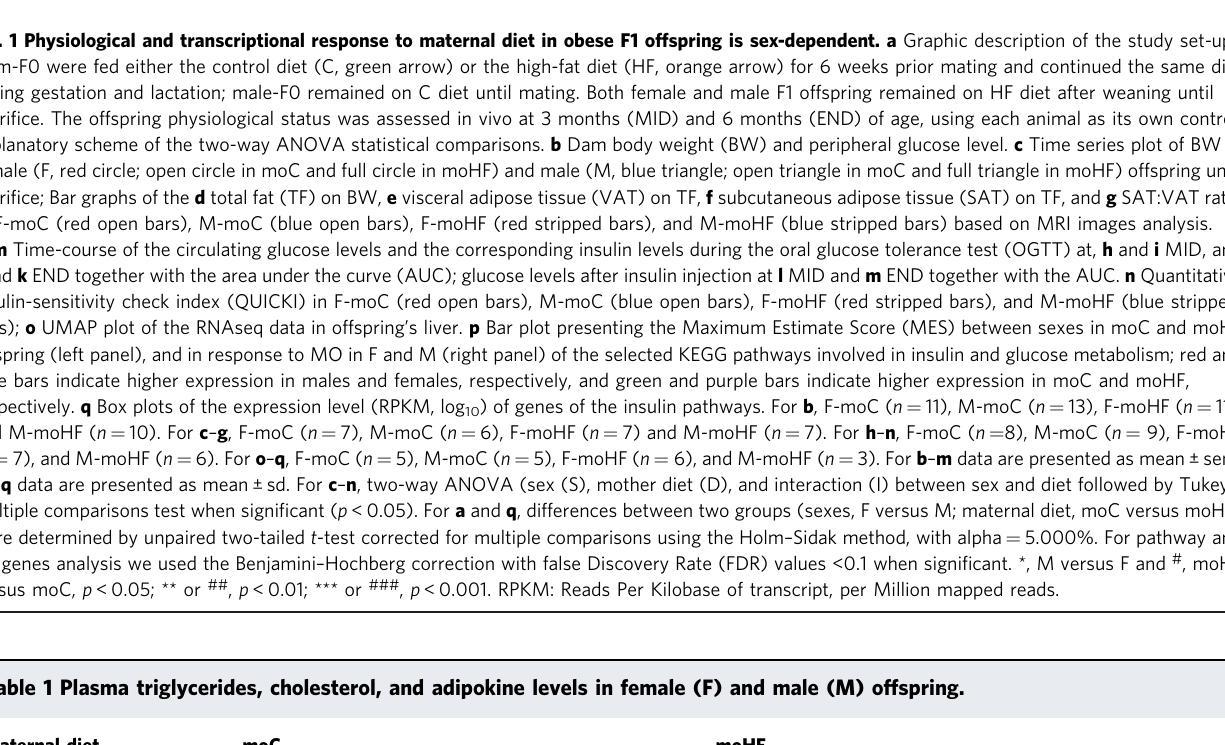
Table 1 Plasma triglycerides, cholesterol, and adipokine levels in female (F) and male (M) offspring. Maternal diet moC moHF